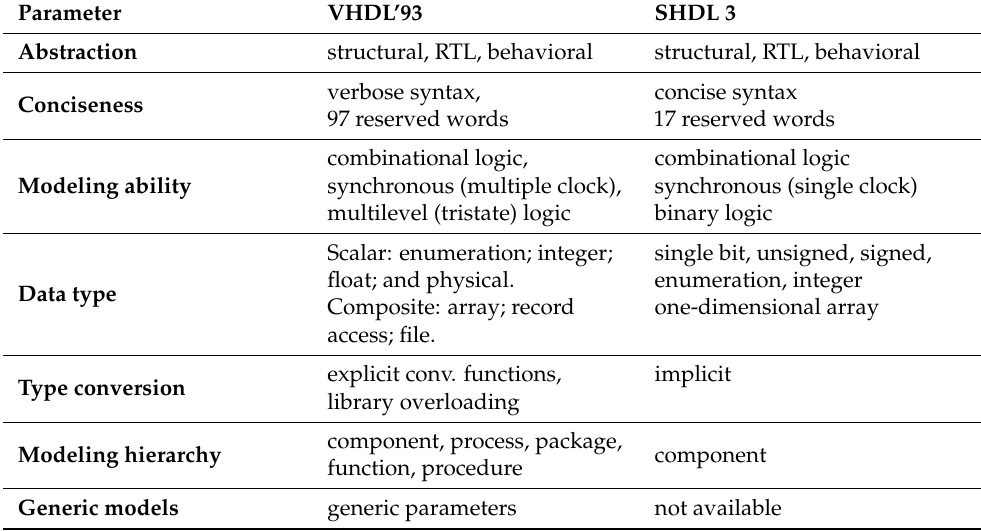
Table 1. Standard VHDL and proposed SHDL